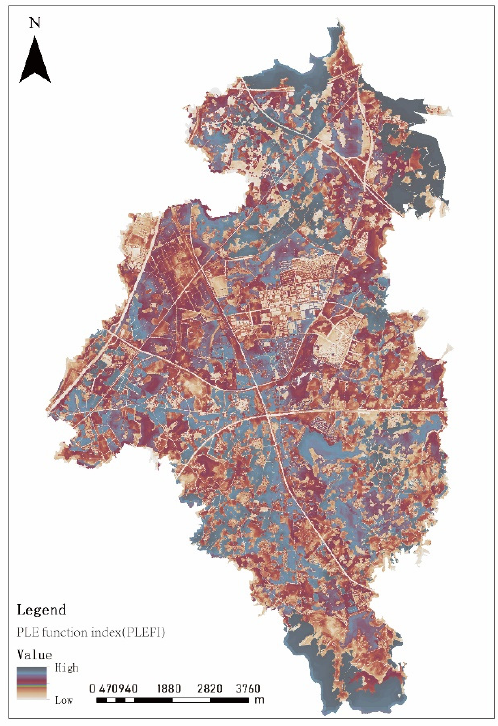
Figure 8. Comprehensive evaluation of PLE functions.